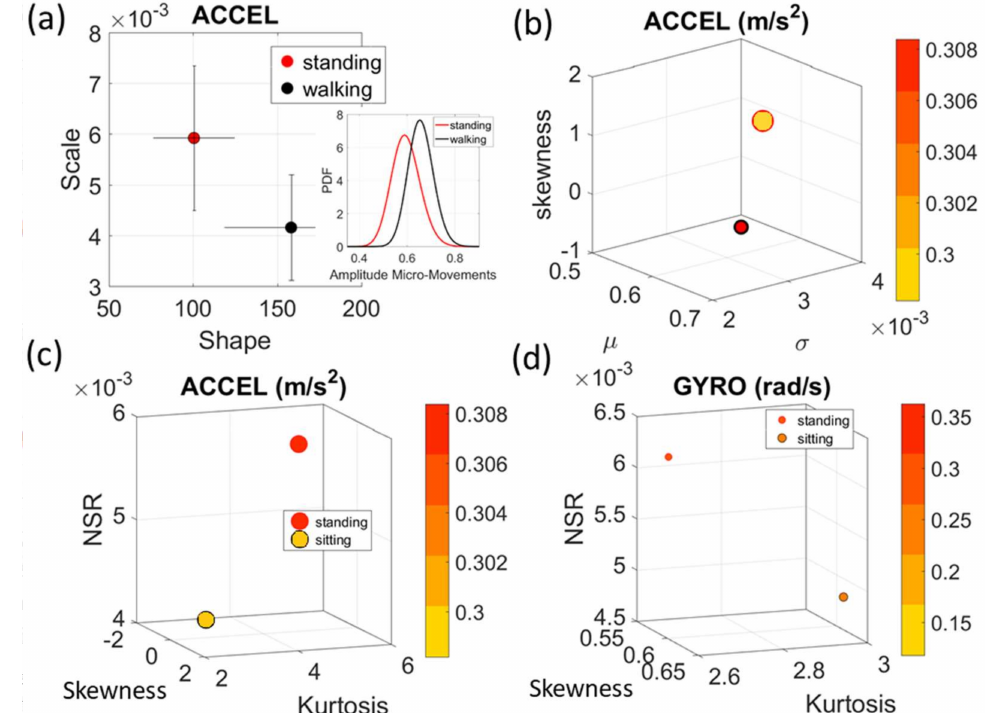
Figure 4. Micro-movements spike trains as a Gamma process. ( a ) The estimated Gamma shape and scale ( a , b ) parameters are plotted on the Gamma parameter plane with 95% confidence intervals for the Kaggle sample summary data (mean acceleration for standing and walking activities). Empirically estimated PDFs are insets. ( b ) The estimated Gamma moments (see text) with the color representing the range of median acceleration values in this example (m/s 2 ) ( c ) Identification of parameter space separating the activities include the skewness, kurtosis and Gamma b -scale (NSR) for the acceleration peak amplitude (m/s 2 ) and the angular velocity peak amplitude (rad/s). ( d ) Same as (c) for the